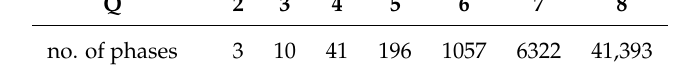
Table 2. Number of phases in the Stochastic Block Model (SBM) with Q communities. Q 2 3 4 5 6 7 8 no. of phases 3 10 41 196 1057 6322